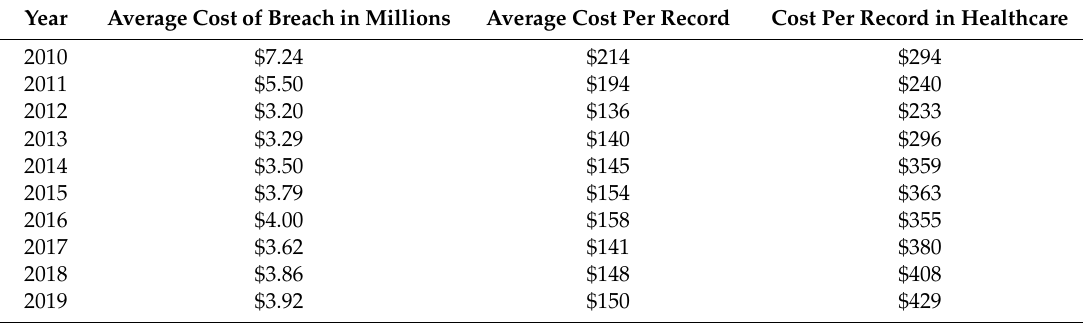
Table 7. Cost of Data Breaches.